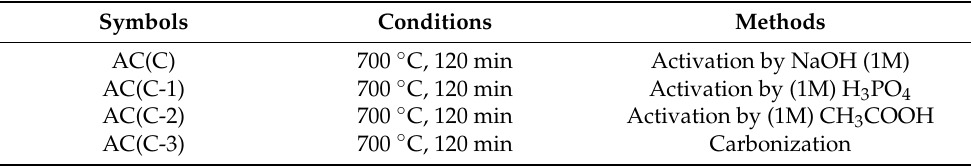
Table 1. The various types of the prepared activated carbon. Symbols